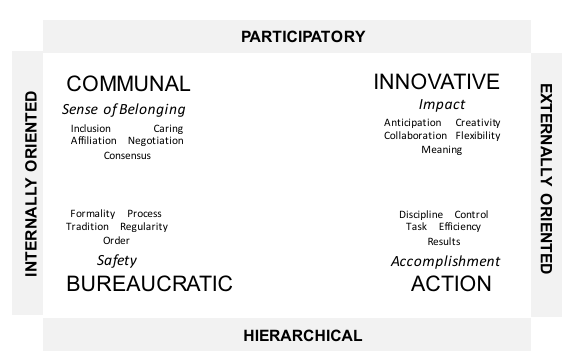
Figure 3. Driving forces and characteristics that characterize organizations. Reprinted from Adaptive Capacity: How organizations can thrive in a changing world (p.60), by J. C. Eichholz, 2014, Greenwich, CT: LID Publishing,